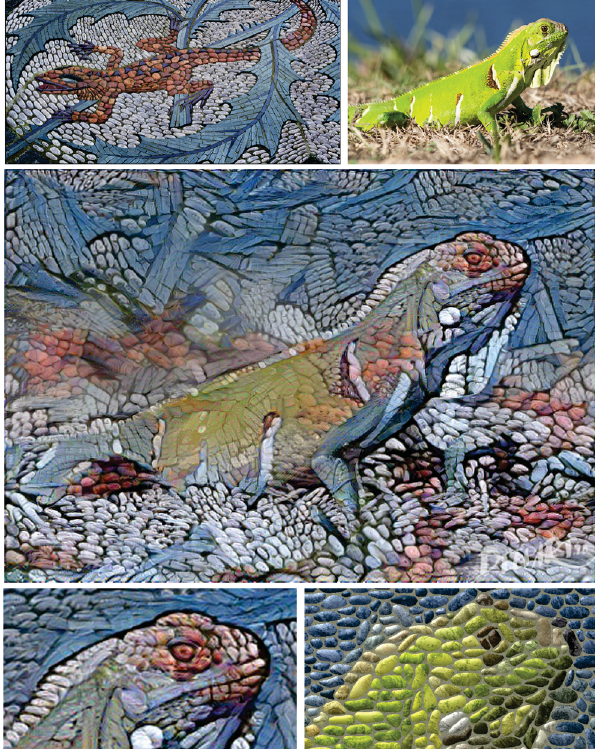
Fig. 17 Comparison with neural style. Top left: style example. Top right: input image. Center: pebble mosaic rendered with neural style [28] as implemented at deepart.io . Bottom left: detail. Bottom right: detail of Fig. 9(bottom).